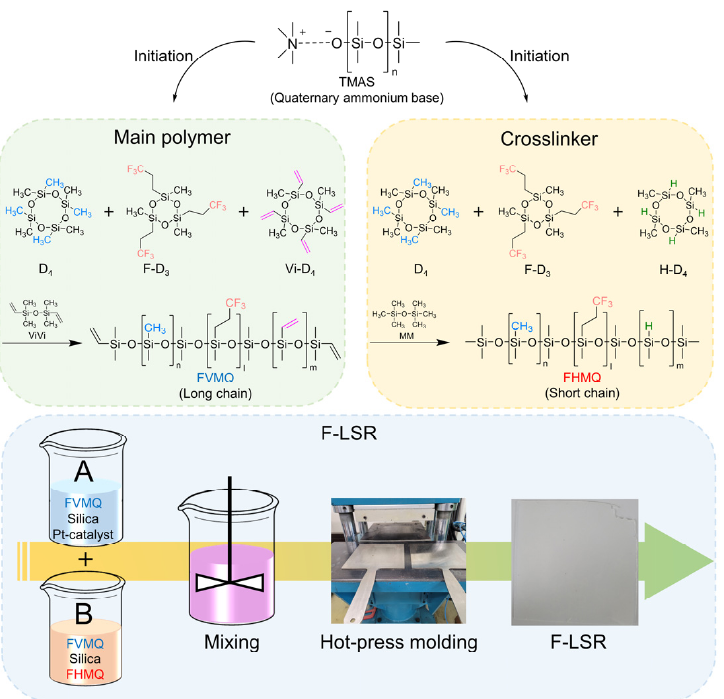
Figure 2. Schematic of all processes for synthesizing fluorosilicone and manufacturing liquid silicone rubber. Table 1. Compositions of reactants for the preparation of FVMQs.